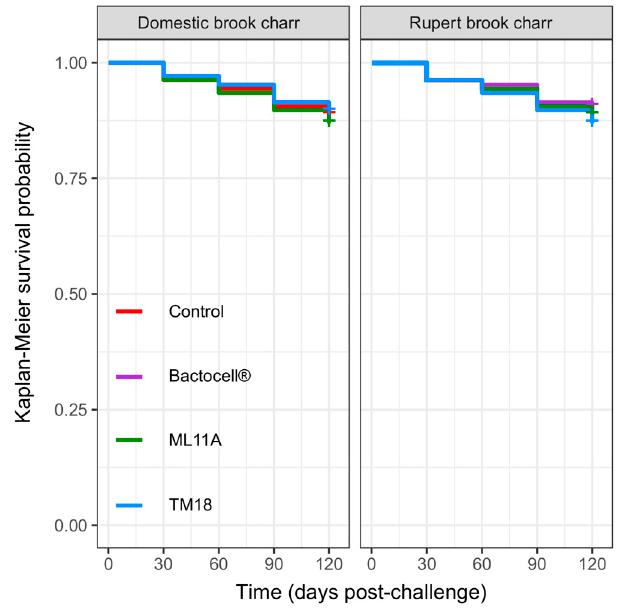
Figure 4. Kaplan-Meier survival probability curves of brook charr receiving 10 5 CFU mL − 1 probiotic treatments per tank on a daily basis. Control: untreated fish. Bactocell ® : fish treated with P. acidilactici MA18 / 5M (Bactocell ® ). ML11A: fish treated with P. fluorescens ML11A. TM18: Fish treated with A. sobria TM18.